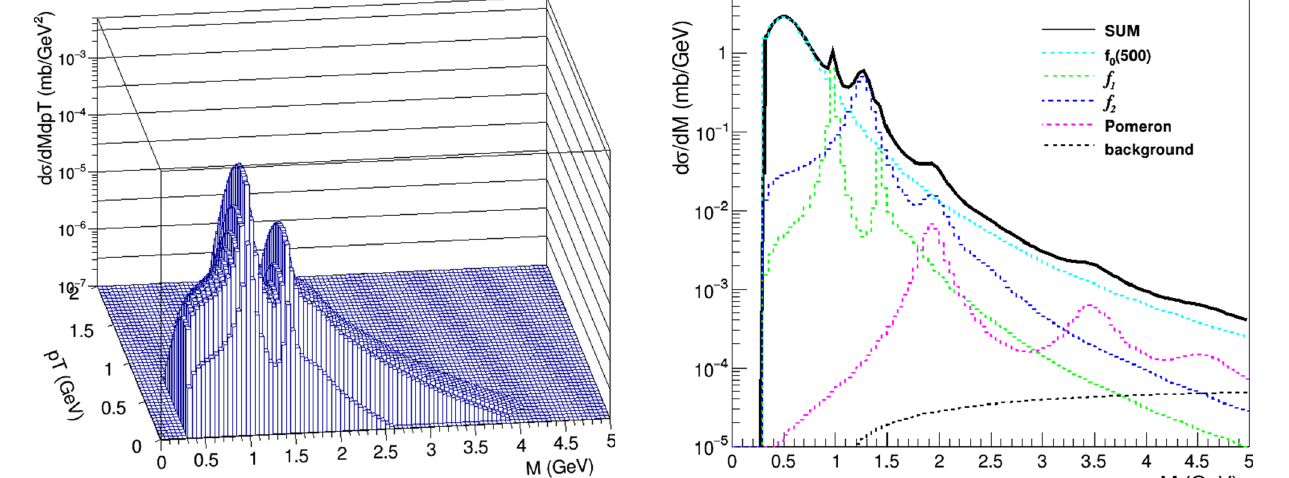
The contributions to the differential meson cross section